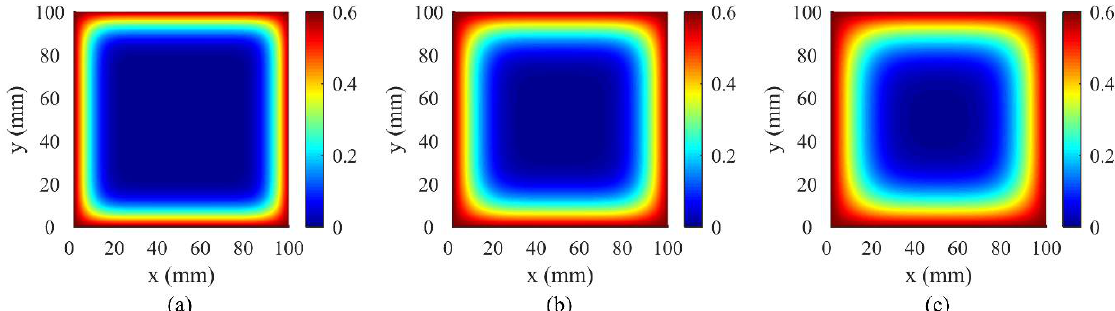
Figure 5. Simulation results for chloride ion concentration in concrete cross-section under various corrosion times: ( a ) t = 120 days; ( b ) t = 240 days; ( c ) t = 360 days.